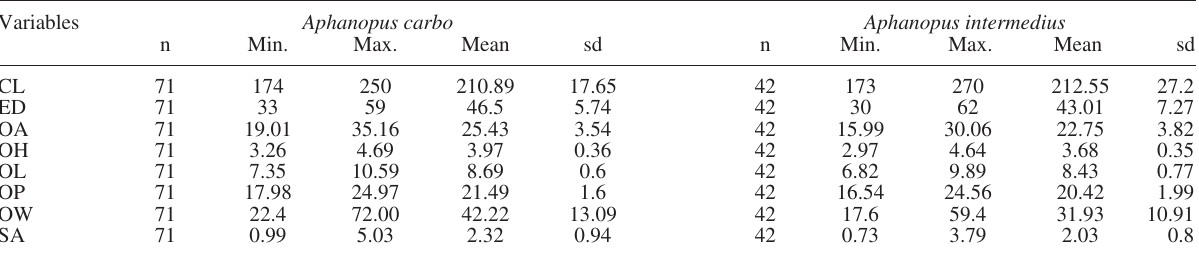
Table 1. – Descriptive statistics of fish and otolith variables in Aphanopus spp. CL, cephalic length; ED, eye diameter; OA, otolith area; OH, otolith height; OL, otolith length; OP, otolith perimeter; OW, otolith weight; SA, sulcus area. Variables